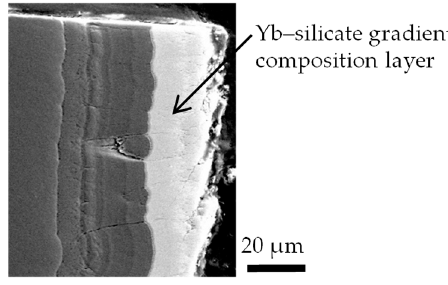
Figure 12. Cross-sectional SEM observation including Region C. Table 12. Line fractions of Regions A, B and C at loaded